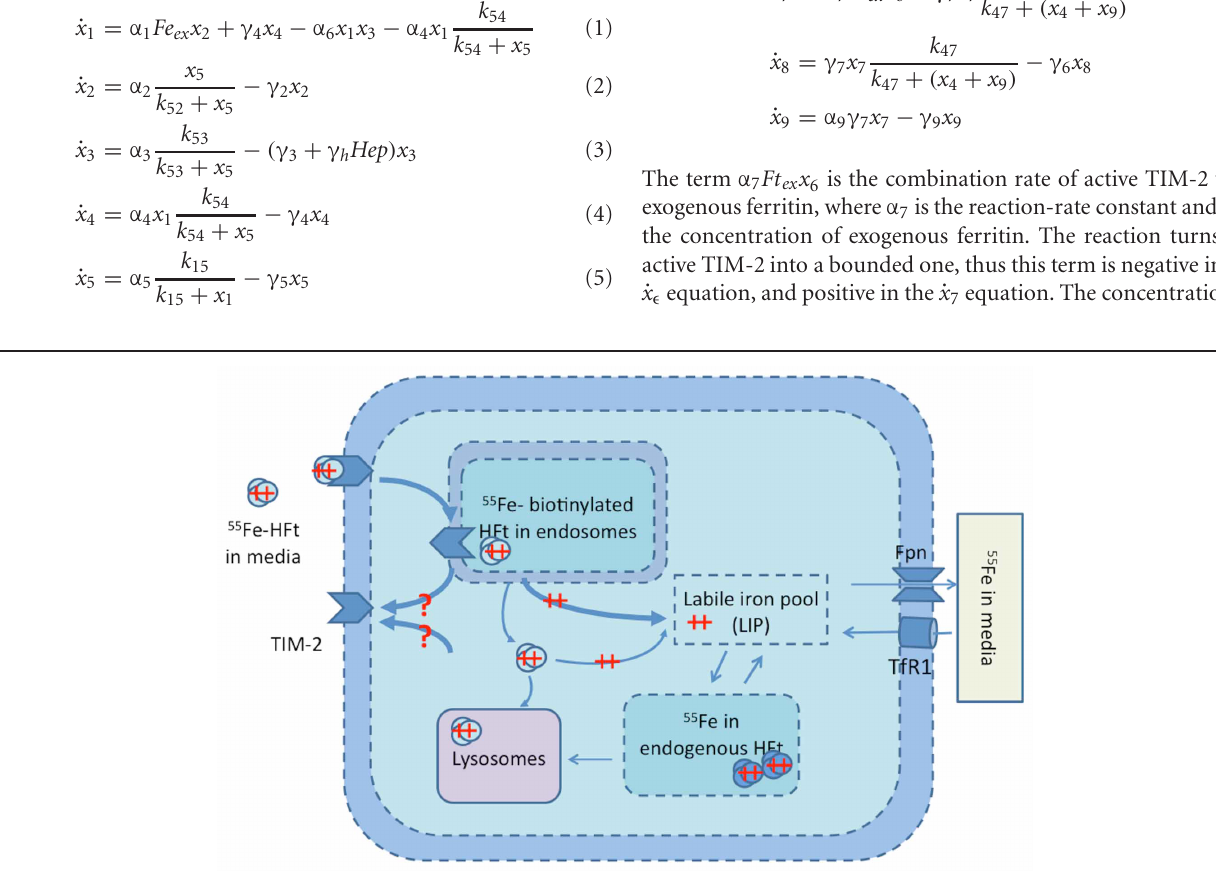
++ represents Fe (ferrous state), and ++ with ovals represents Fe-HFt. Unshaded ovals are for external HFt, and shaded ovals are for endogenous HFt. The question marks (?) represent pathways that do not have any direct experimental